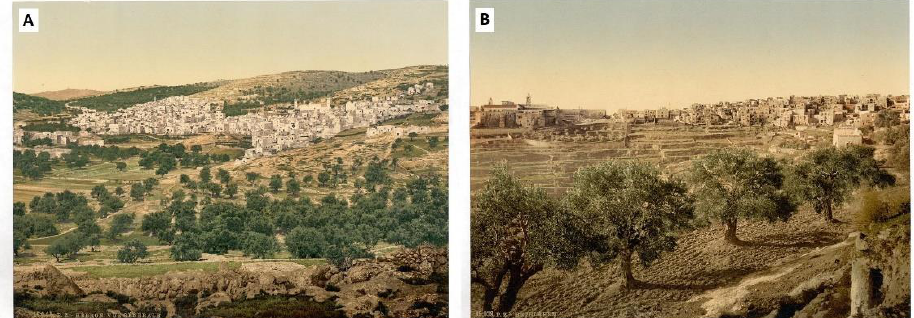
Figure 4. Olive groves surroundings the city of Hebron in a photo from 1890–1900 ( A ) [65]. Olive trees in the front of the photo showing the city of Bethlehem from 1890–1900 ( B ) [66].